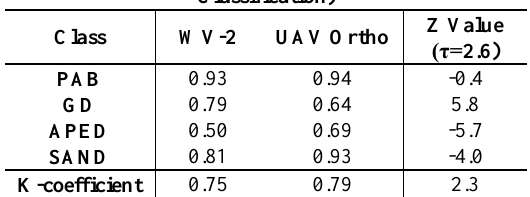
Table 5. Object: K-Conditional coefficients and Z-test results